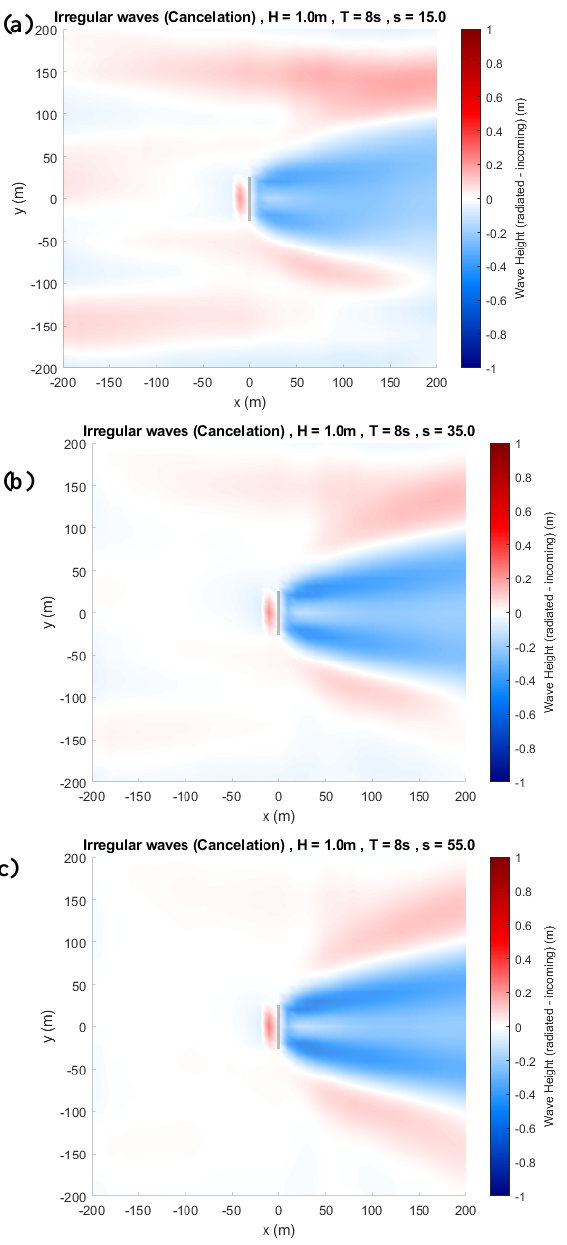
Figure 12: The significant wave height of time averaged wave field for short crested wave conditions for different spreading indexes of, (a) 𝑠𝑖 = 15 , (b) 𝑠𝑖 = 35 , and (c) 𝑠𝑖 = 55 with 𝑠 𝜆 ⁄ = 0.5 . V. E FFICIENCY A NALYSIS OF THE C YC